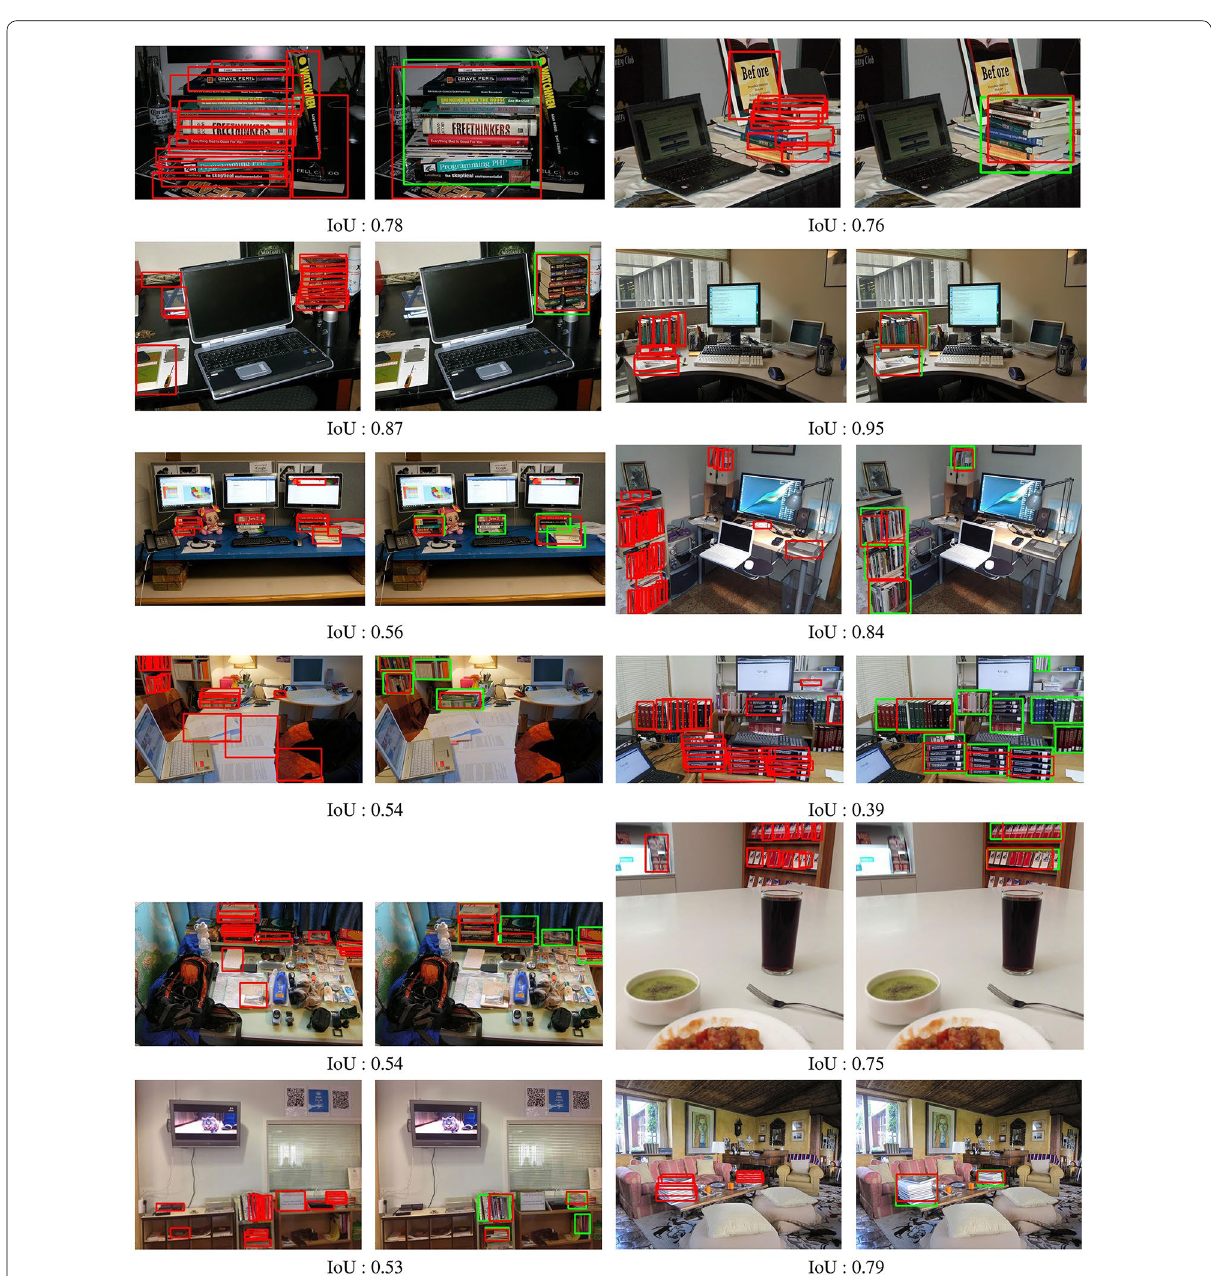
Fig. 19 Extraction examples by the proposed method (1). For each pair, the left side is the result of the SSD and the right side is the result of extraction by the proposed method (red BB: predicted, green BB: